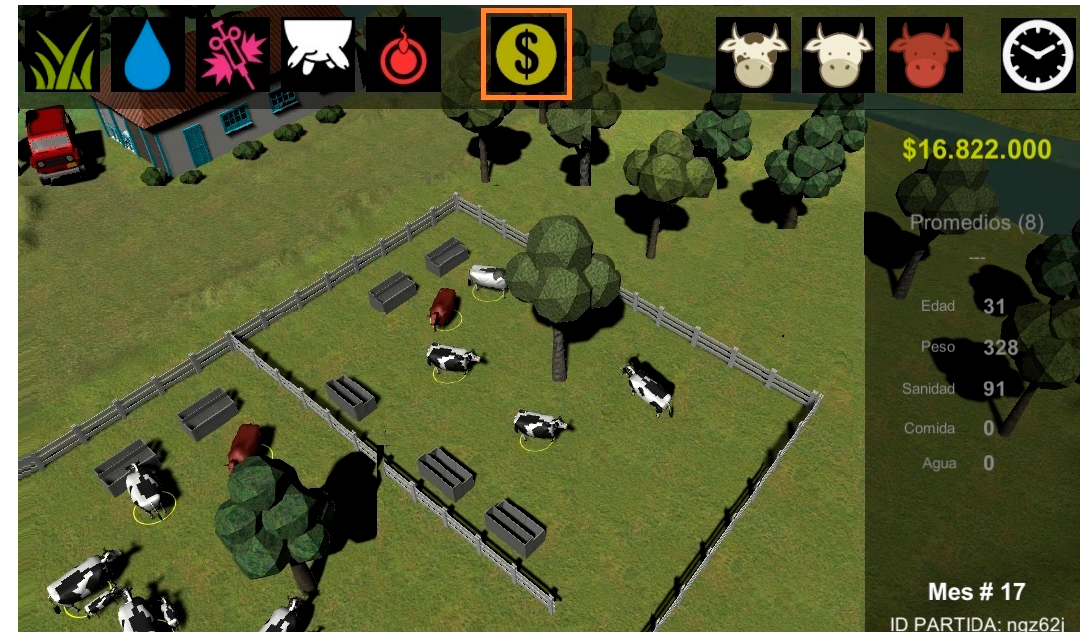
Figure 4. Example of a session of the serious video